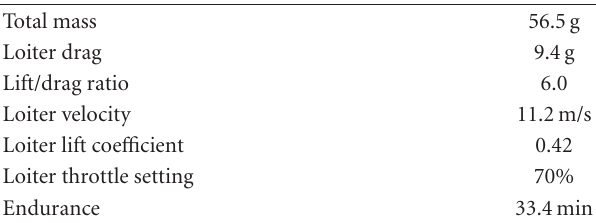
Figure 10: Graphic representation of rotary-wing configurations: (a) conventional configuration, (b) ducted coaxial, (c) conventional coaxial, (d) rotors side by side, (e) synchropter, (f) conventional tandem, (g) quad rotor [27]. Table 1: Performance summary for the first-generation Black Widow MAV